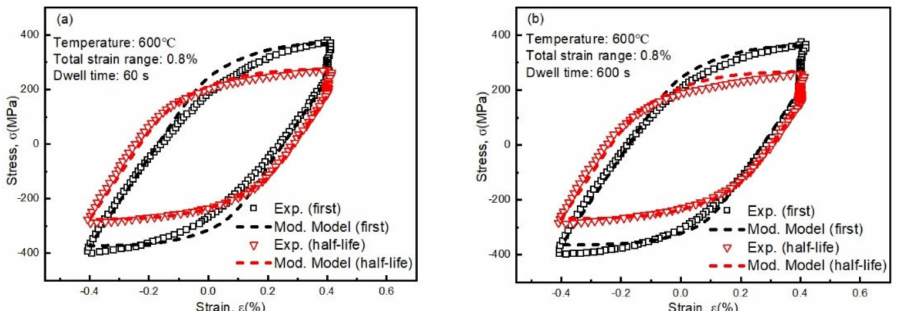
Figure 13. Comparison of simulated hysteresis loops of first and half-life cycles and experimental results at 0.8% total strain range with di ff erent dwell times under 600 ◦ C: ( a ) 60 s and ( b ) 600